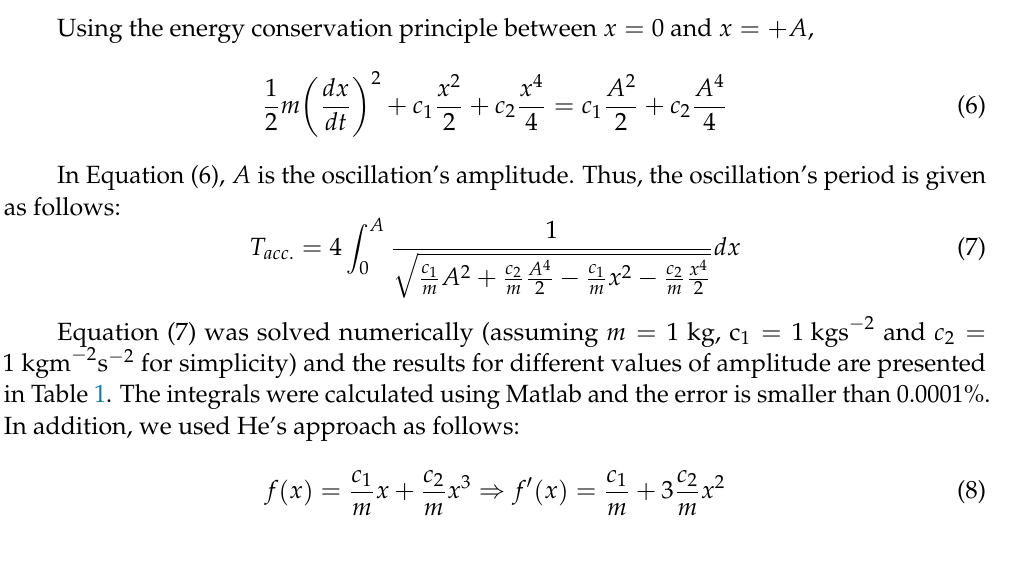
Table 1. Accurate and approximate solutions for Duffing equation for m = 1 kg, c 1 = 1 kgs − 2 and c 2 = 1 kgm − 2 s − 2